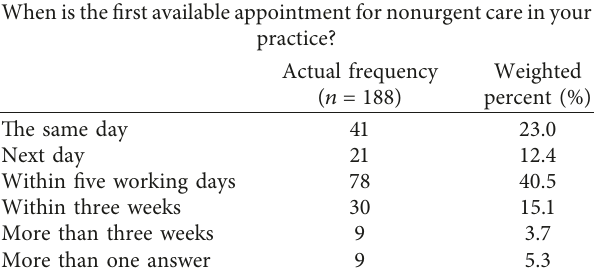
Table 2: Availability of appointments for nonurgent care.